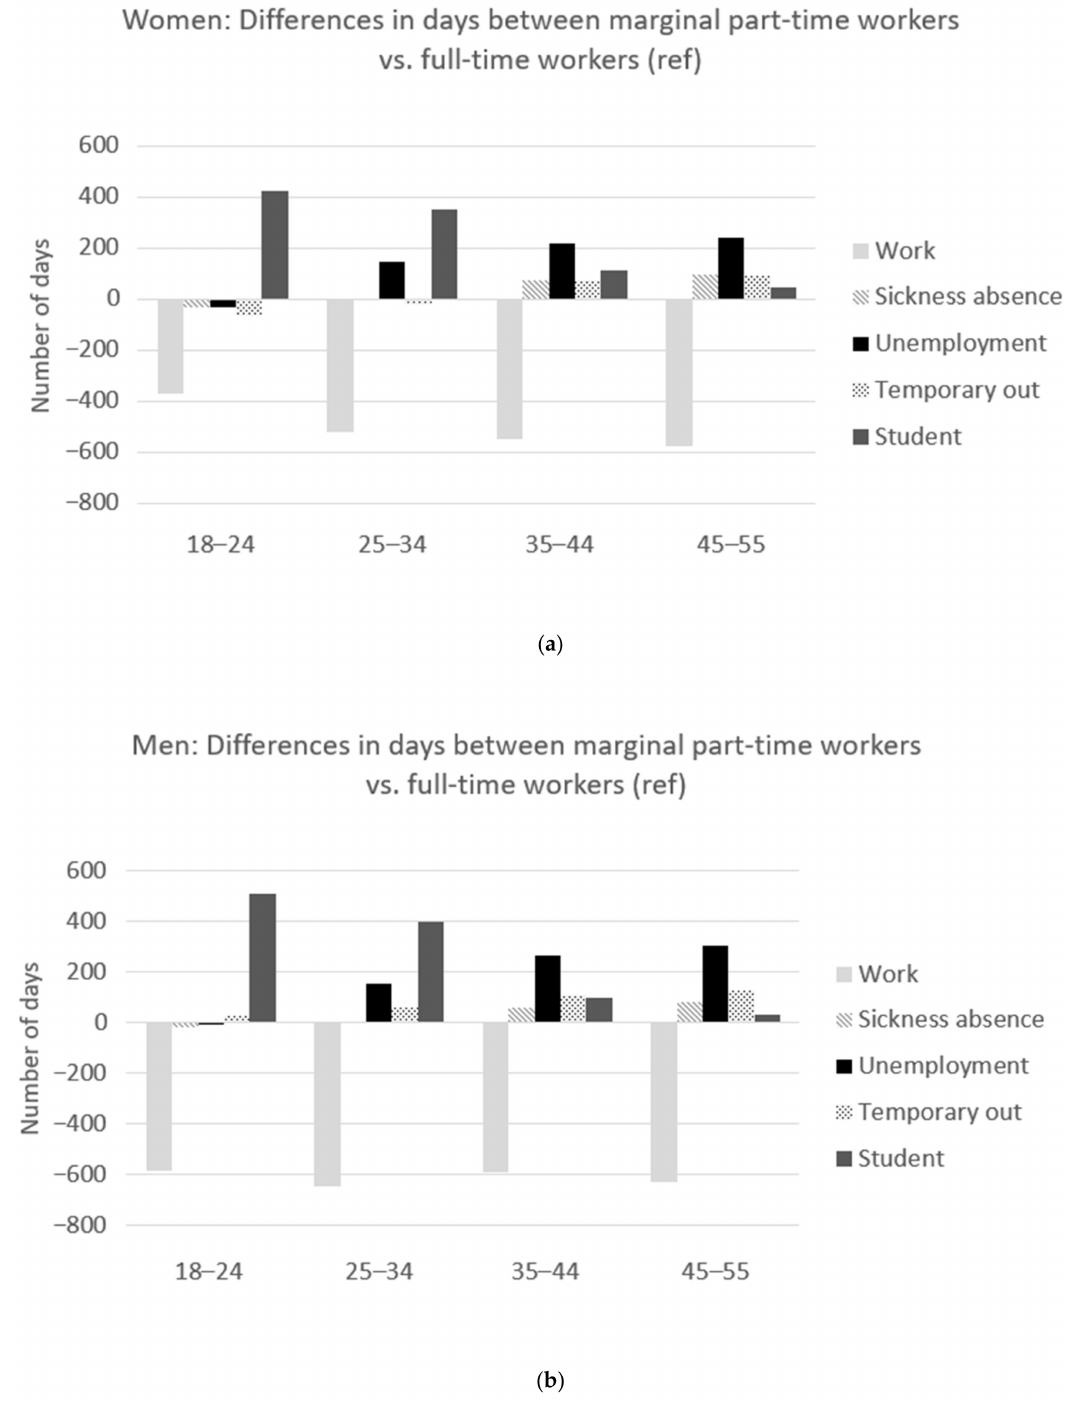
Figure 3. The difference between the estimated days in the recurrent states for marginal part-time workers compared with full-time workers (reference) over the five years of follow-up by age group and in women ( a ) and men ( b ). Days represent periods within a given state, which also includes days off (e.g., weekends). Figure 3 shows that a marginal part-time worker at baseline in the following five years is estimated to have between 370–647 fewer days of work without any social benefits compared with a full-time worker at baseline. Instead, a marginal part-time worker is estimated to spend more days as a student. In addition, marginal part-time workers ≥ 25 years old are also estimated to have more days of unemployment, long-term sickness absence, and being temporarily out of the labor